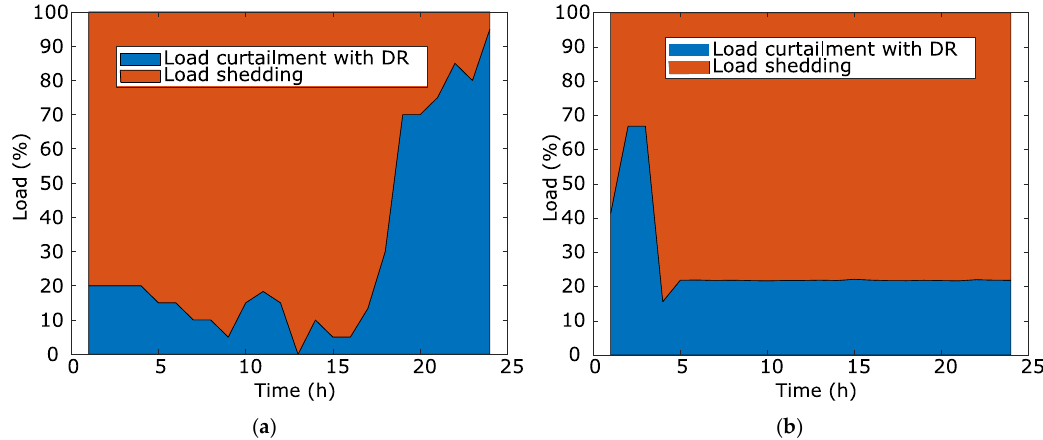
Figure 9. Load profile with DR: ( a ) 0-1 knapsack problem; ( b ) demand response function.